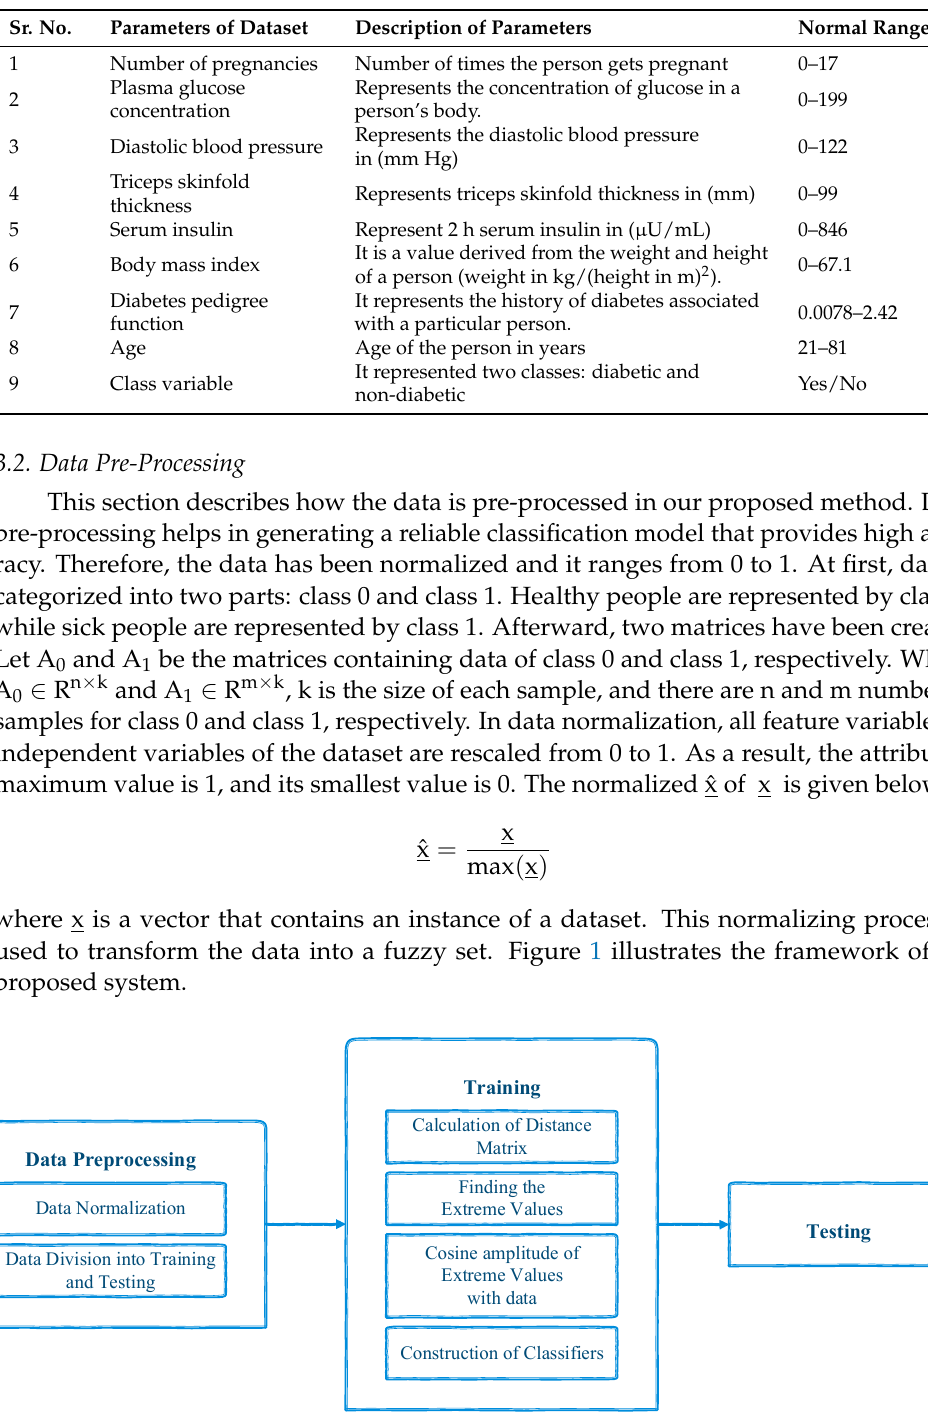
Table 4. Dataset division into training and testing.